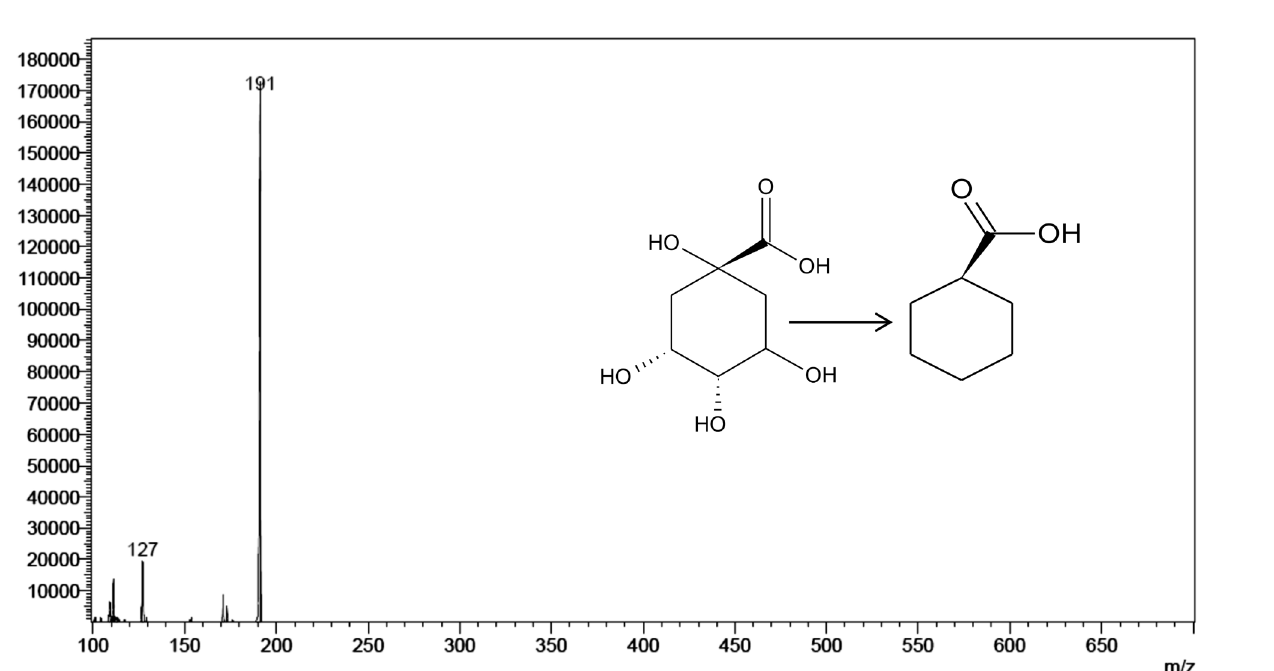
FIGURE 2 - The MS² spectrum of the precursor ion m/z 191 using 20eV of collision energy.